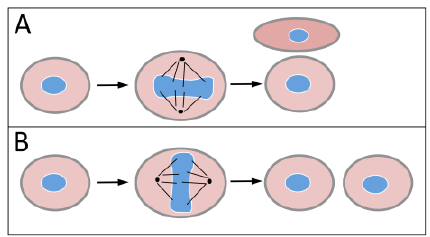
Figure 1. Cell division in a squamous epithelium. ( A ) Asymmetric cell division of a basal epithelial cell yields two unequal daughter cells. One remains an undifferentiated, DNA synthesis competent basal epithelial cell whereas the other daughter is a differentiating epithelial cell that will terminally withdraw from the cell division cycle. Human papillomaviruses (HPV) genomes segregated into such cells will retain these cells in a DNA replication competent state and complete their full replicative life cycle including viral progeny synthesis. ( B ) Symmetric cell division will yield two basal like cells. This mode of cell division is to replenish basal epithelial cell during wound healing. After the initial infection, HPVs establish a long-term persistent infection of these cells where the viral genome is maintained at a low copy number. The viral genome undergoes replication every time the cell replicates its genome. See text for